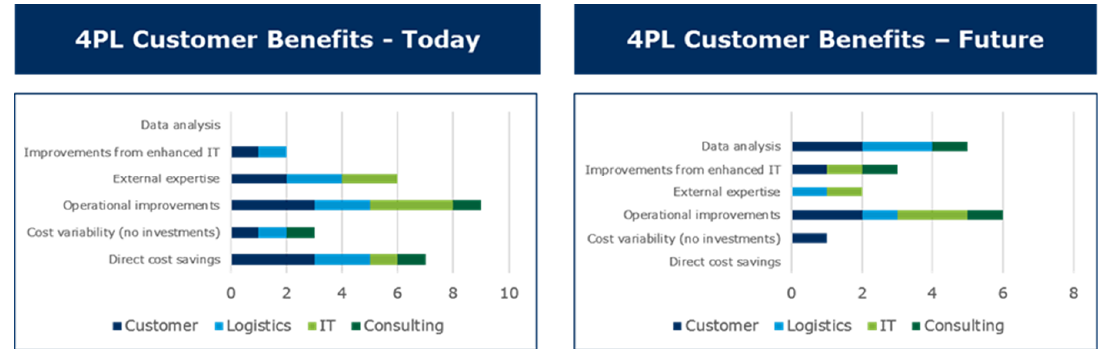
Figure 4. Comparison of 4PL customer benefits: results from semi-structured interviews.